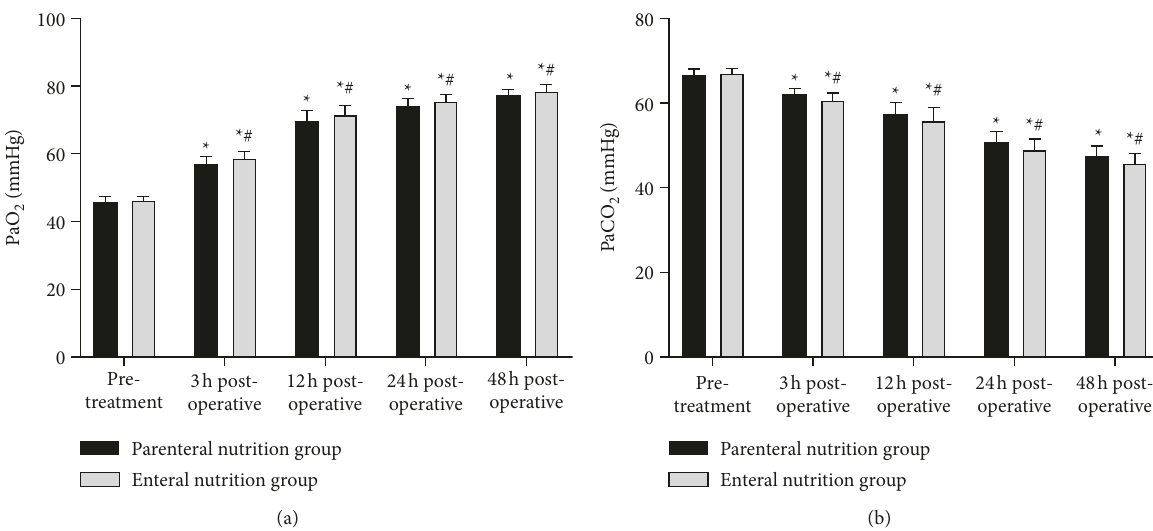
Figure 3: Comparison of blood gas indexes between two groups. (a) PaO treatment, # comparison with the parenteral nutrition group at the same time point. There is a statistical difference.